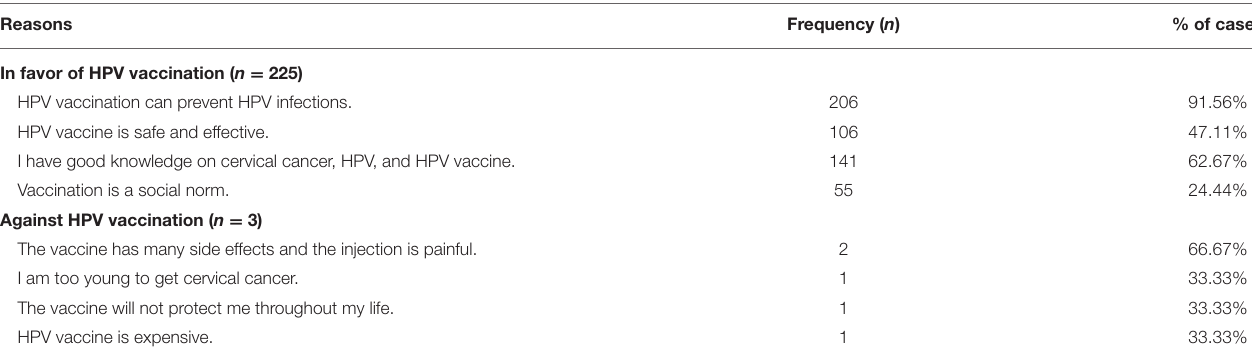
TABLE 3 | Most important reasons in favor of or against HPV